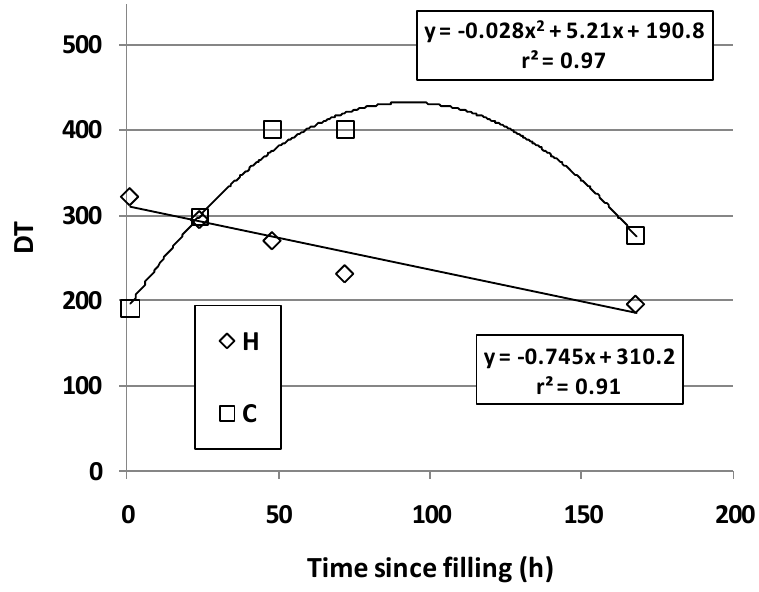
Figure 3. An example of how odor concentration (DT) as measured by laboratory dynamic triangular forced-choice olfactometry (DTFCO) changes with time in homemade (H)